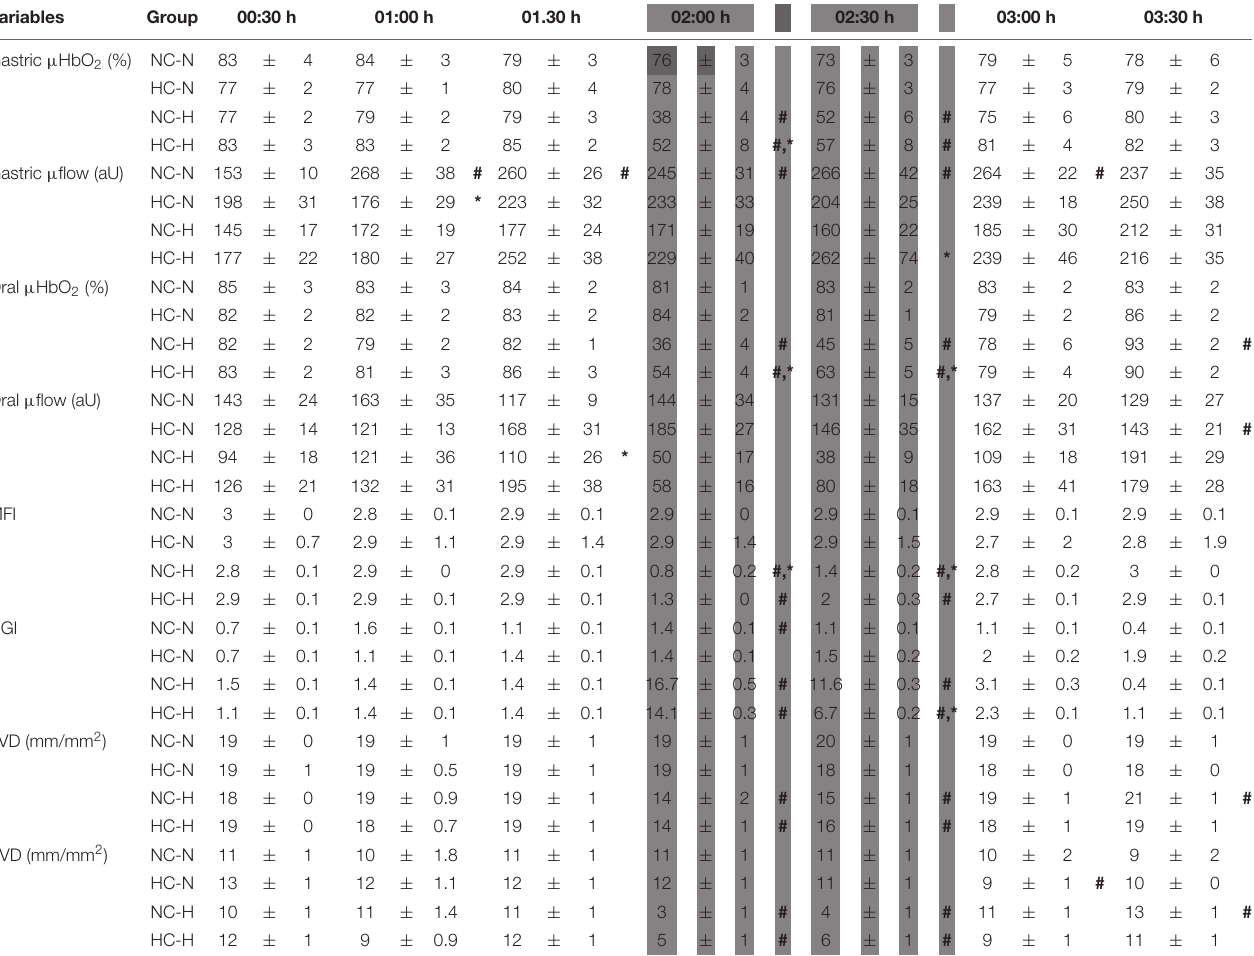
Microvascular oxygenation ( µ HbO 2 ) in percentage (%) and microvascular flow ( µ flow) in arbitrary units (aU) were measured at the gastric and oral surface using reflectance spectrophotometry and laser Doppler flowmetry. Microvascular flow index (MFI), heterogeneity index (HGI), total vessel density (TVD) in (mm/mm 2 ) and PVD in (mm/mm 2 ) were evaluated by incident dark field imagine. One hour of acute hemorrhage is marked gray. Data are presented as mean ± SEM for n = 6 dogs (MFI and HGI n = 5). # p < 0.05 vs. baseline, *p < 0.05 vs. normoxic control group. 2-way ANOVA for repeated measurements followed by Bonferroni post-hoc